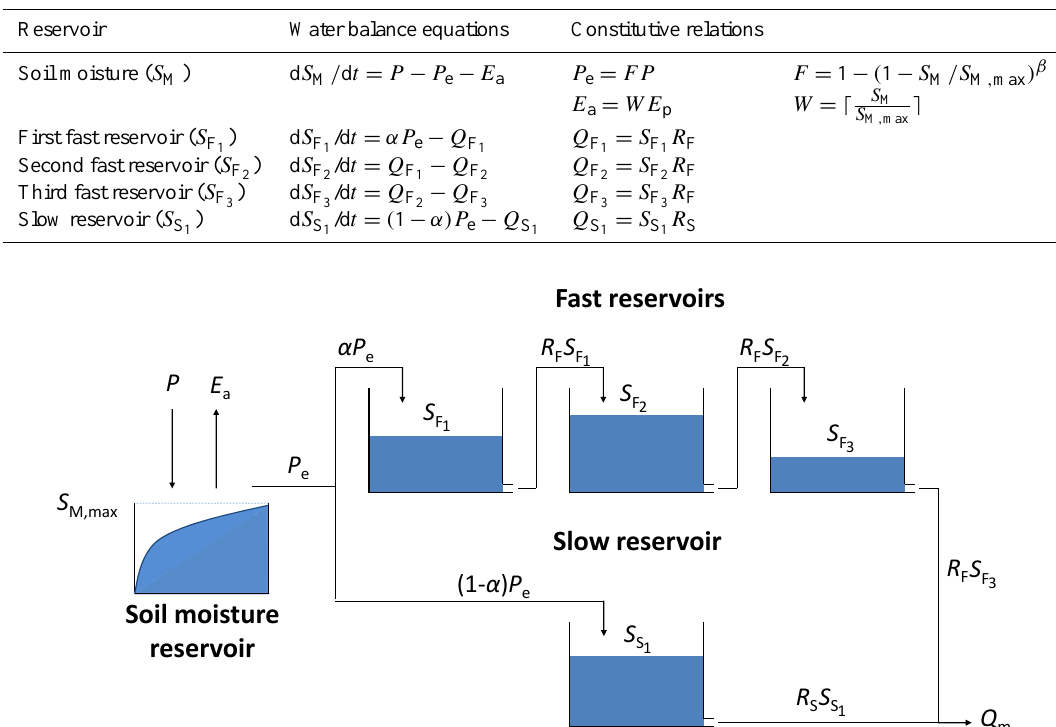
Fig. 2. Schematic illustration of HyMod rainfall/runoff conceptual